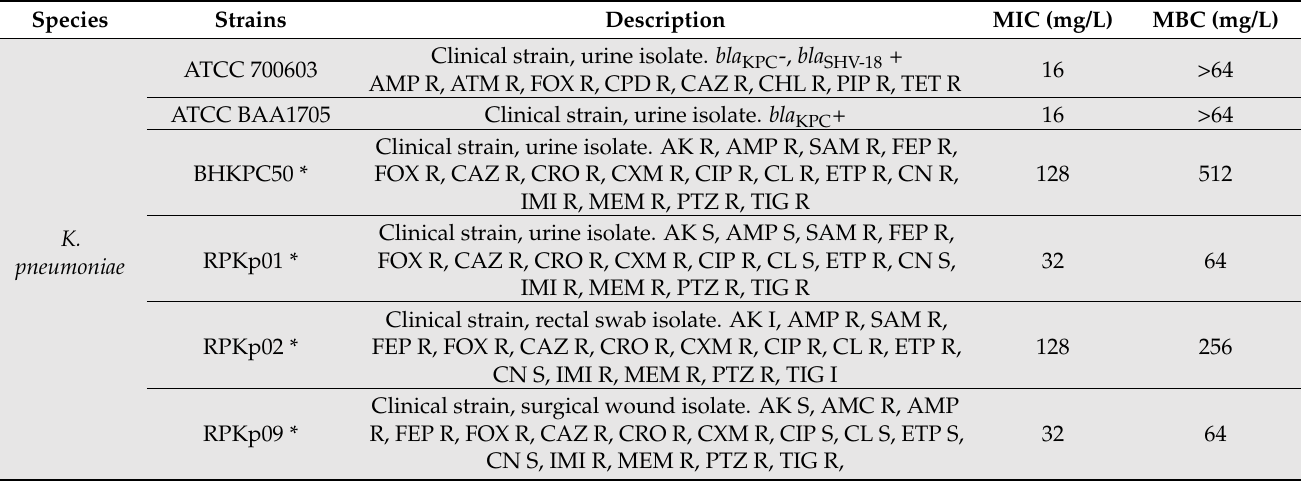
Table A2. MIC and MBC of Pln149-PEP20 against Gram-negative